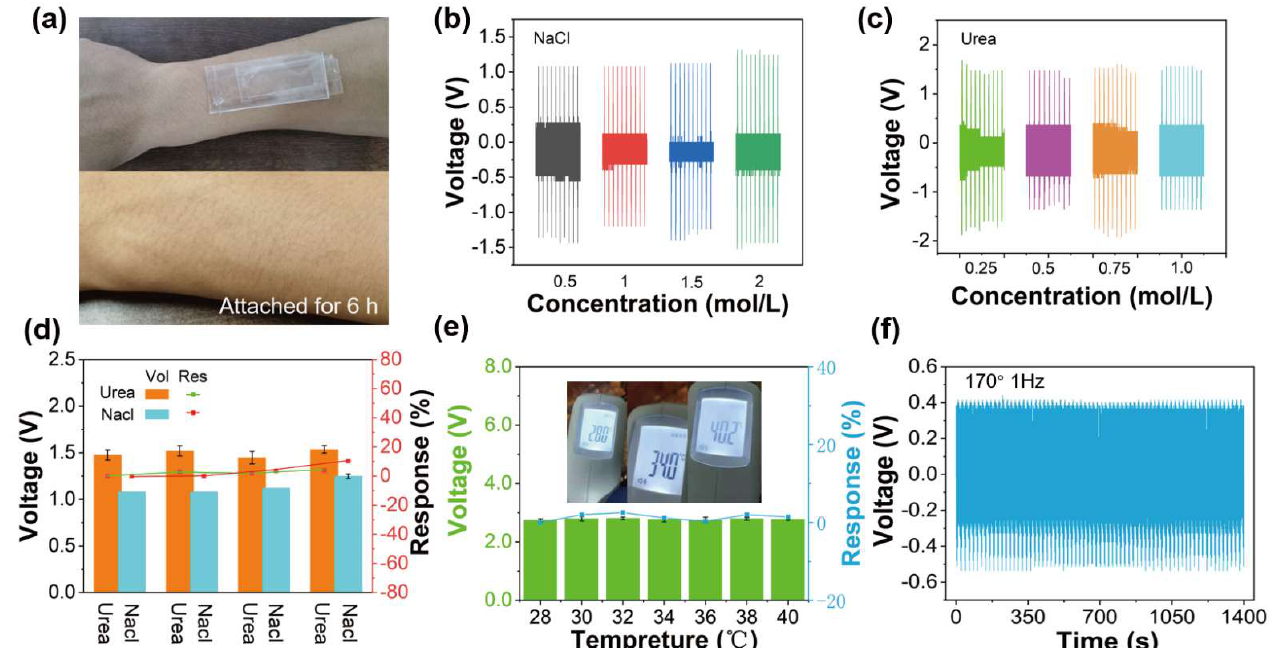
Figure 3. Physiological monitoring properties of TSB-PENG. ( a ) Image of TSB-PENG attaches to the arm for 6 h. ( b , c ) Outputting piezoelectric voltage of TSB-PENG in different concentrations of NaCl and urea. ( d ) Response of outputting piezoelectric voltage of TSB-PENG is in different concentrations of NaCl and urea. ( e ) Outputting piezoelectric voltage of WSB-PENG is at different temperatures. ( f ) Durability property of TSB-PENG.